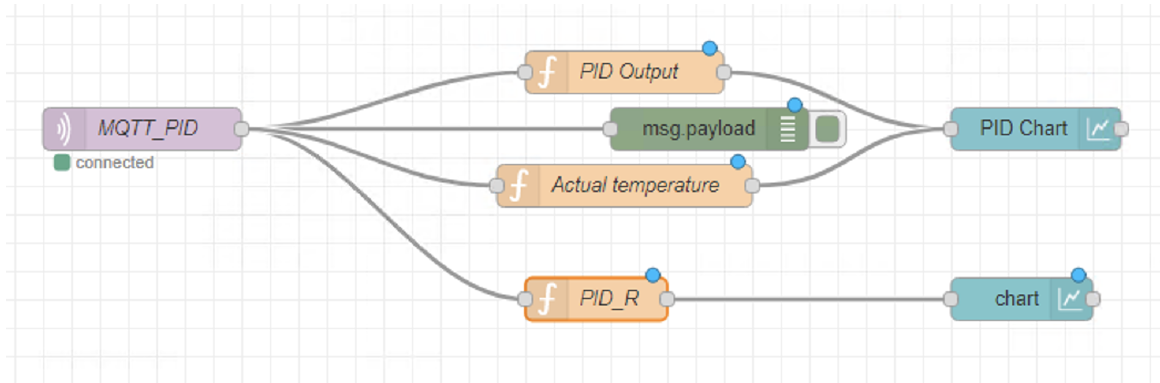
Figure 15. PID function block specialised for temperature control.